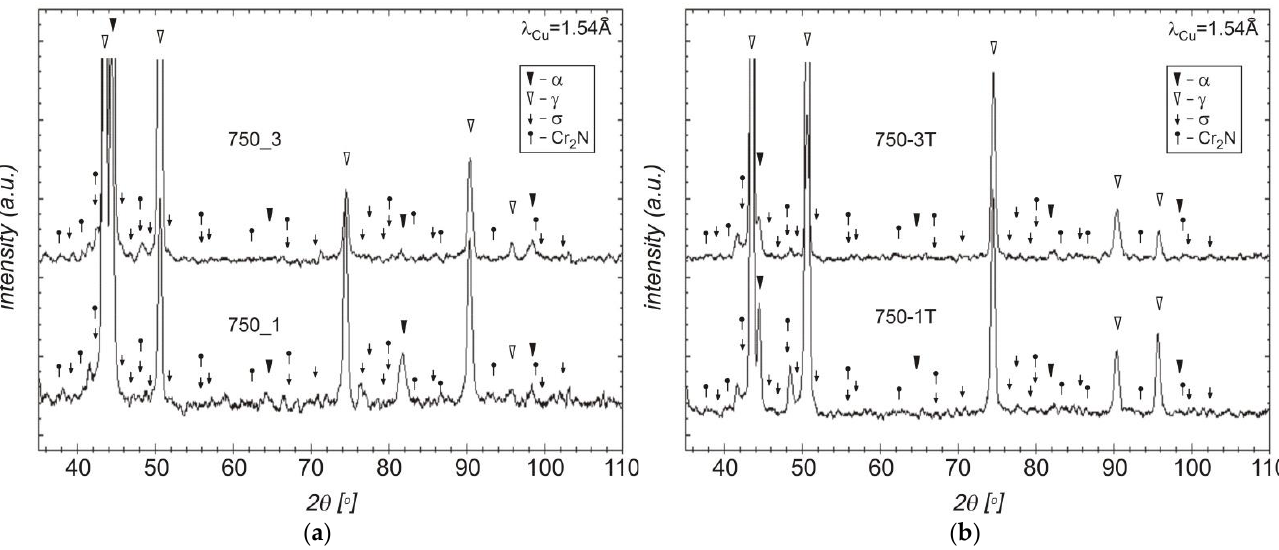
Figure 7. Diffractogram of tested cast steel after holding at 750 °C for 1 and 3 h: ( a ) traditional etch- ing; ( b ) deep etching (T in denotations).